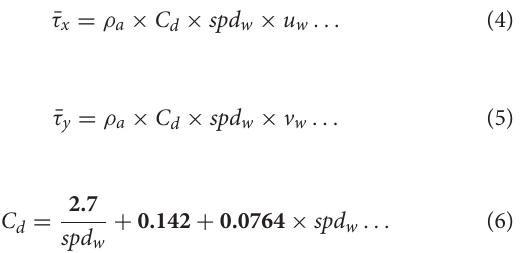
Frontiers in Marine Science |